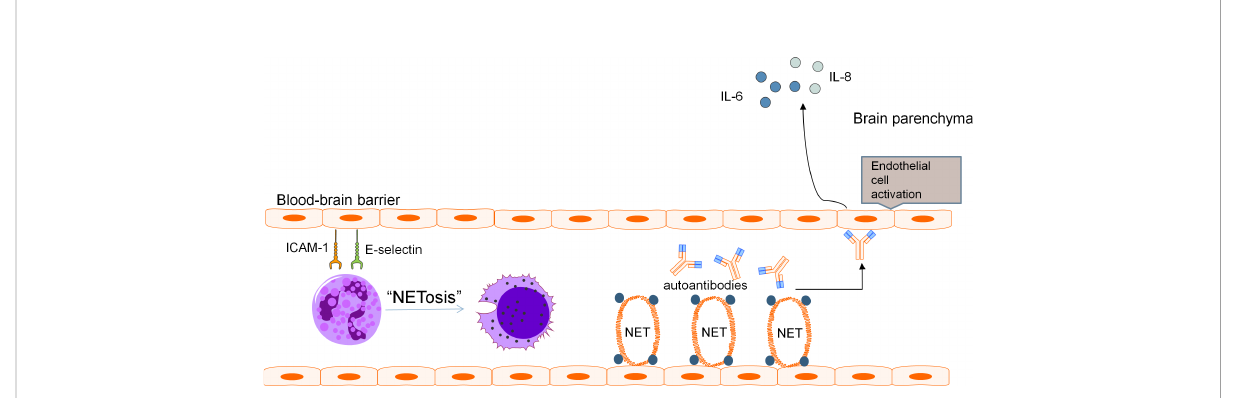
FIGURE 1 Pathogenic mechanism of BBB disruption. Blood-brain barrier disruption in NPSLE has been found to be related to various distinct but potentially complementary pathways involving neutrophils and their cellular products. Adhesion molecules ICAM-1 and E-selectin present on the vasculature of the brain promote neutrophil arrest and adhesion, leading to recruitment of pathogenic neutrophils to the BBB. These neutrophils produce NETs which cause direct endothelial damage and serve as a source of antigens for the development of autoantibodies including aPL and anti-NR2A/B antibodies. These autoantibodies can further aggravate endothelial damage and promote endothelial activation. The downstream effect is increased permeability of the BBB and secretion of pro-in fl ammatory cytokines including IL-6 and